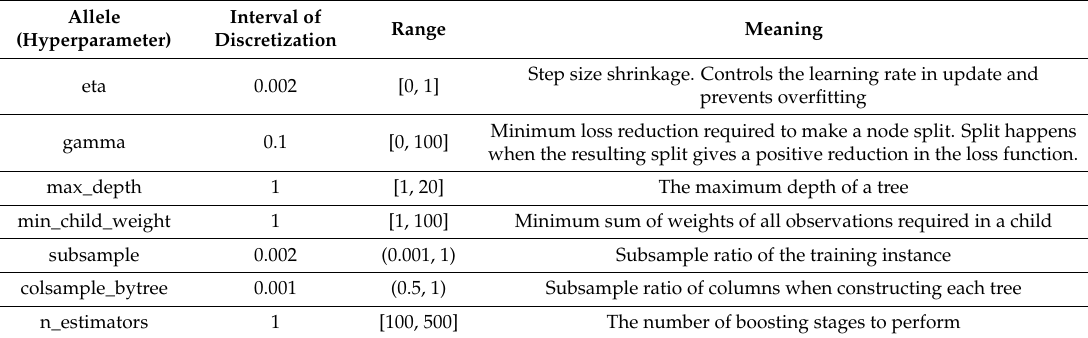
Table 5. Content of chromosome of GA applied for optimizing the values of hyperparameters of XGBoost.